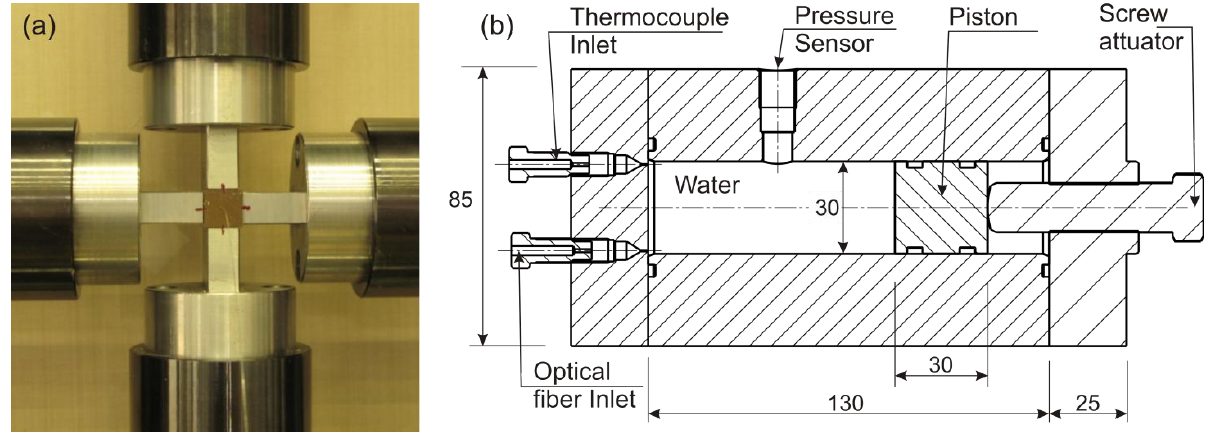
Figure 3. ( a ) FBG equipped specimen and loading actuators for biaxial testing, ( b ) Schematic of the pressure chamber setup (dimensions in